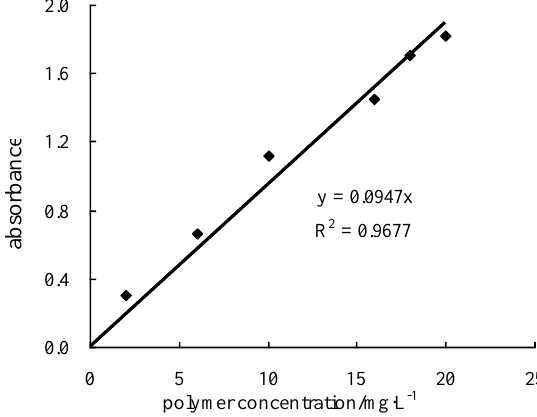
Figure 4. The polymer concentration–absorbance standard curve.